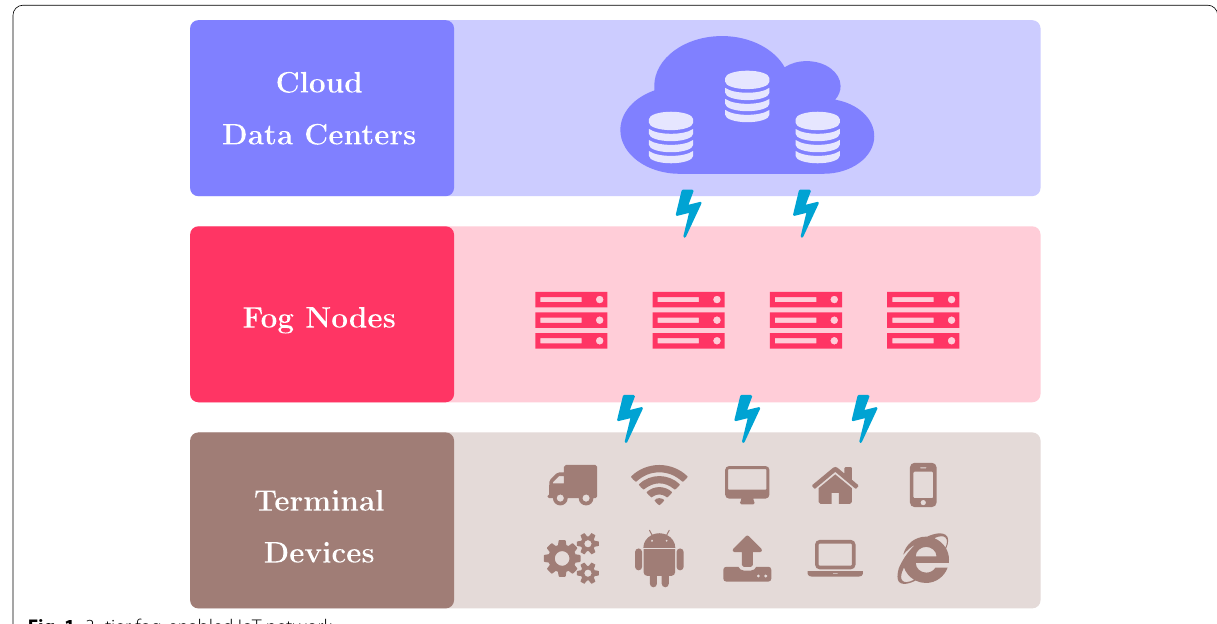
Fig. 1 3–tier fog‑enabled IoT